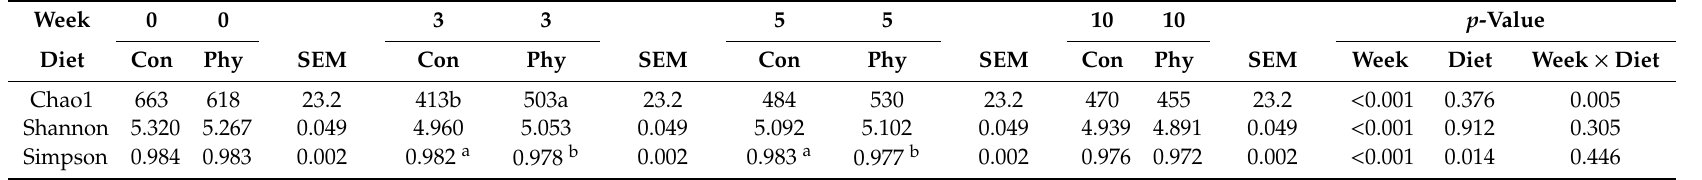
Table 4. Alpha diversity metrices in feces of pigs fed diets with or without phytase supplementation 1 .